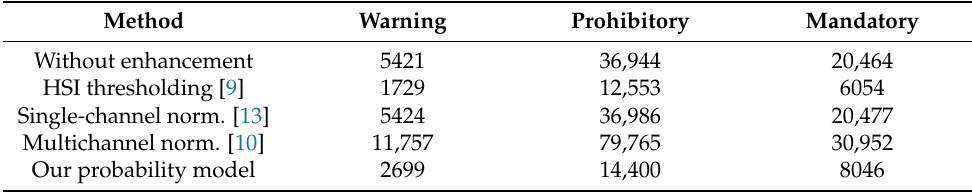
Table 5. The number of bounding boxes generated on the Swedish dataset.